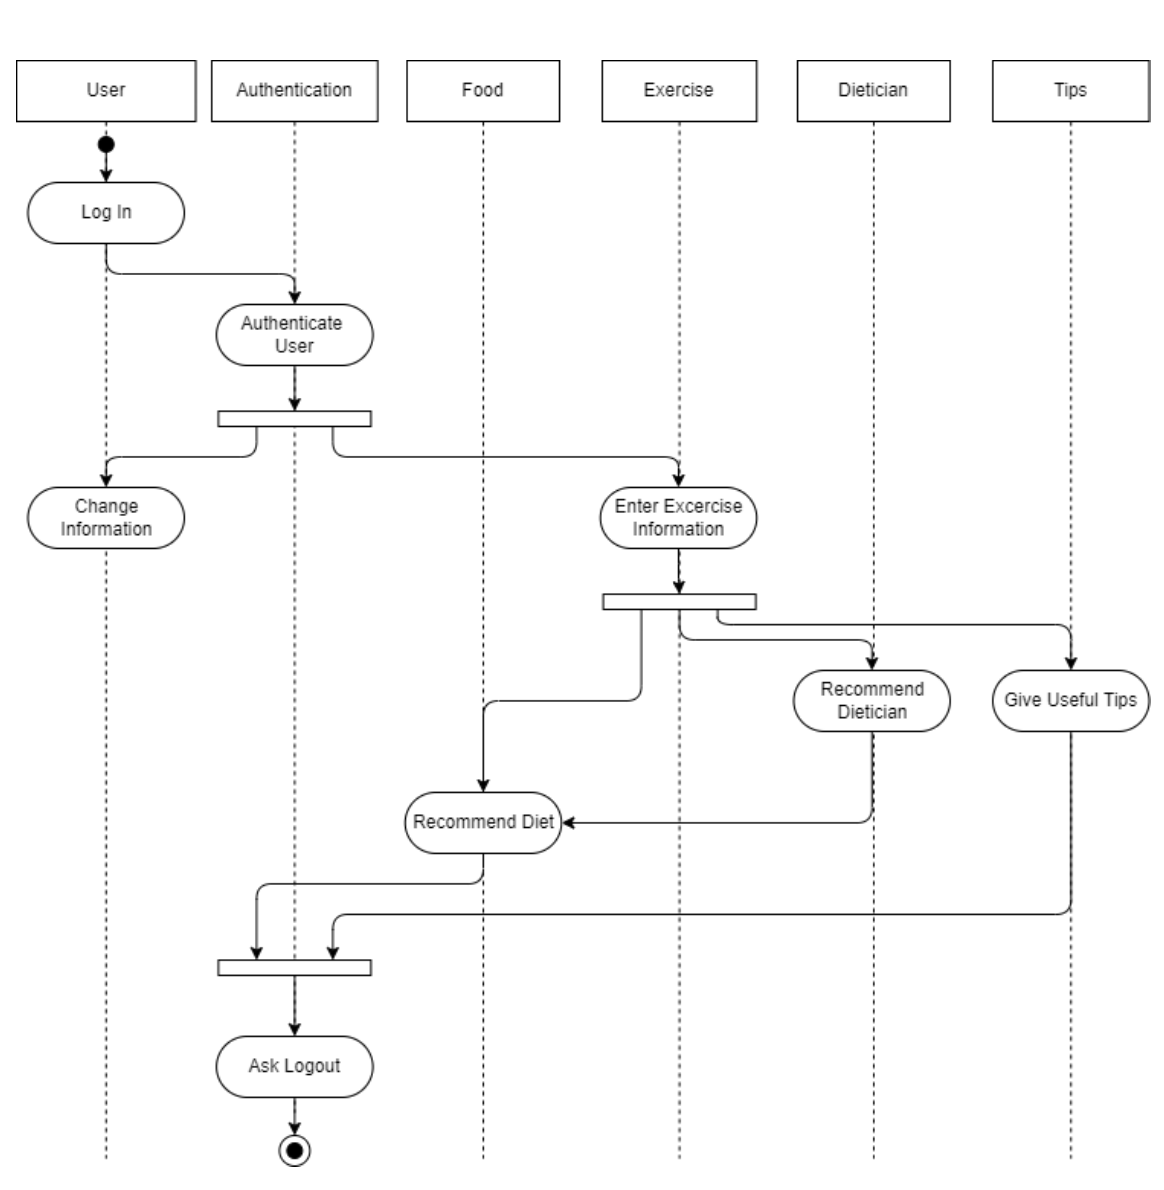
Figure 18. Activity Diagram of proposed